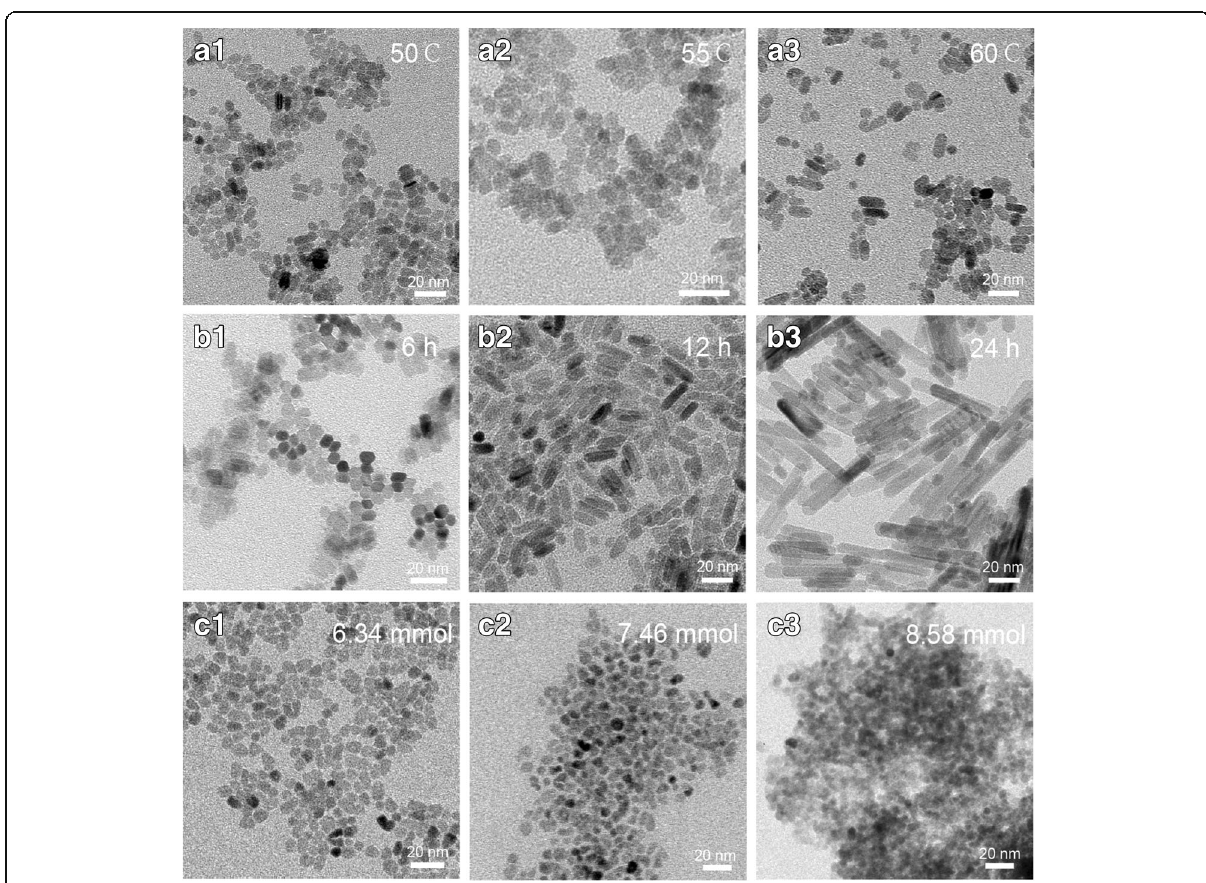
Fig. 5 TEM images of ZnO NPs with different morphologies obtained by changing reaction a time and b temperature as well as c NaOH content. a1 – 3, b1 – 3, and c1 – 3 correspond to samples 2 – 4, sample 10 – 12, and sample 15 – 17, respectively. See Fig. 1 for a reference of these